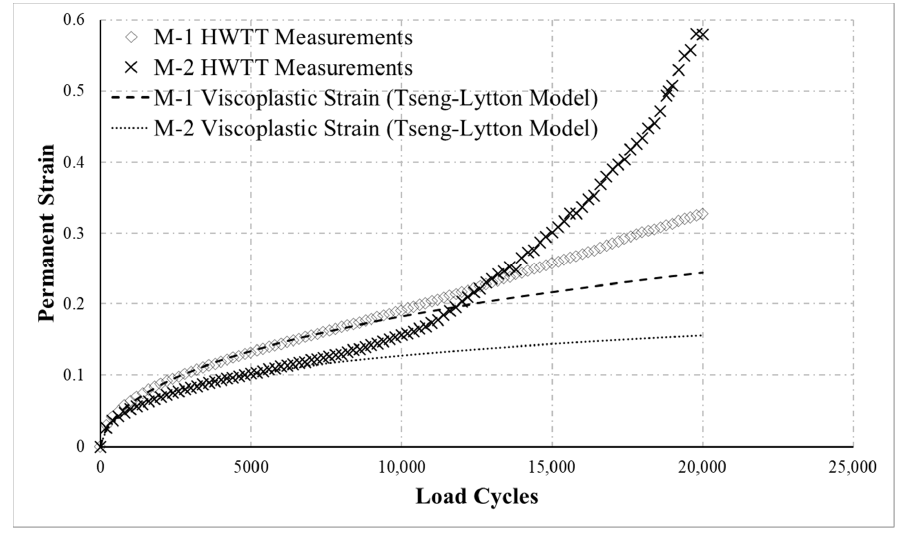
Figure 6. HWTT results for M-1 and M-2. Table 1. Rutting at different numbers of load cycles in the HWTT, RI , and ∆𝜀 (cid:2869)(cid:2868),(cid:2868)(cid:2868)(cid:2868)(cid:3049)(cid:3043) results.